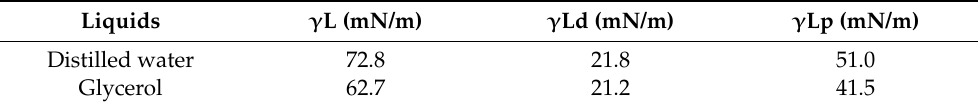
Table 2. The surface tension parameters of measuring liquids.